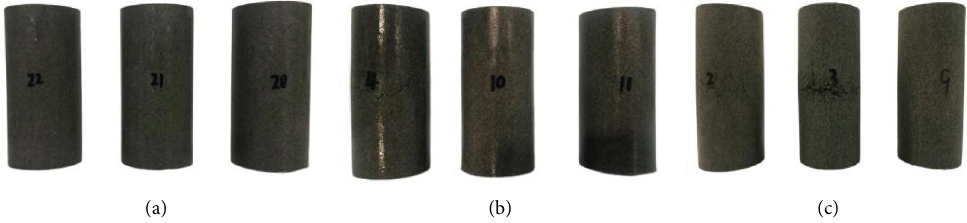
Figure 5: Freeze-thaw cycle results of green sandstone specimens. (a) 20 cycles. (b) 30 cycles. (c) 40